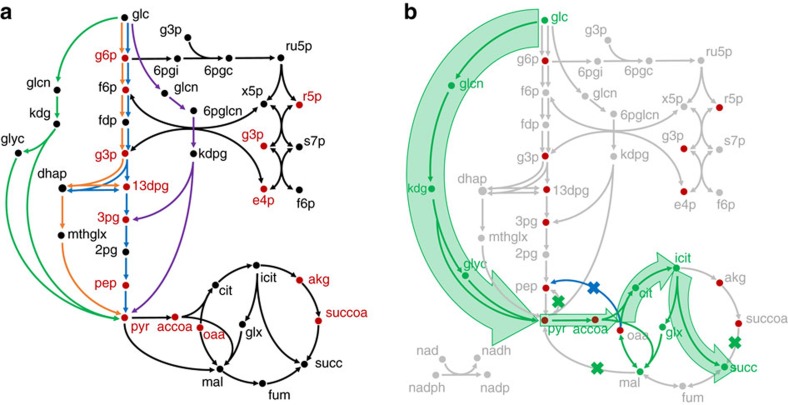
Simplified metabolic map of the glucose consuming pathways.(a) The unique pathways analysed in this study are indicated by the coloured lines. Green: glucose synthetic; blue: glycolytic EMP; orange: MG bypass; purple: ED pathway. (b) Sample cut set strategy for synthetic glucose pathway shows that the structure is amenable to a metabolic valve topology which bypasses most of the biomass precursors. These precursors of the central metabolism are required for growth and have been identified in red. The green x marks which reactions have been identified for deletion by the algorithm to design for orthogonality. The blue x marks the metabolite valve. Synthetic pathways attempt to bypass these precursors as well as the points of regulation. A similar branched topology was not observed for natural glycolytic pathways.